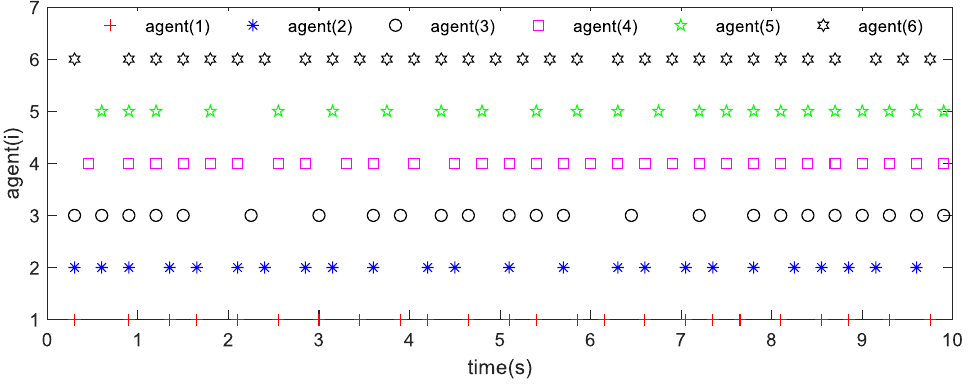
Figure 8. Evolution of error signals for each agent.